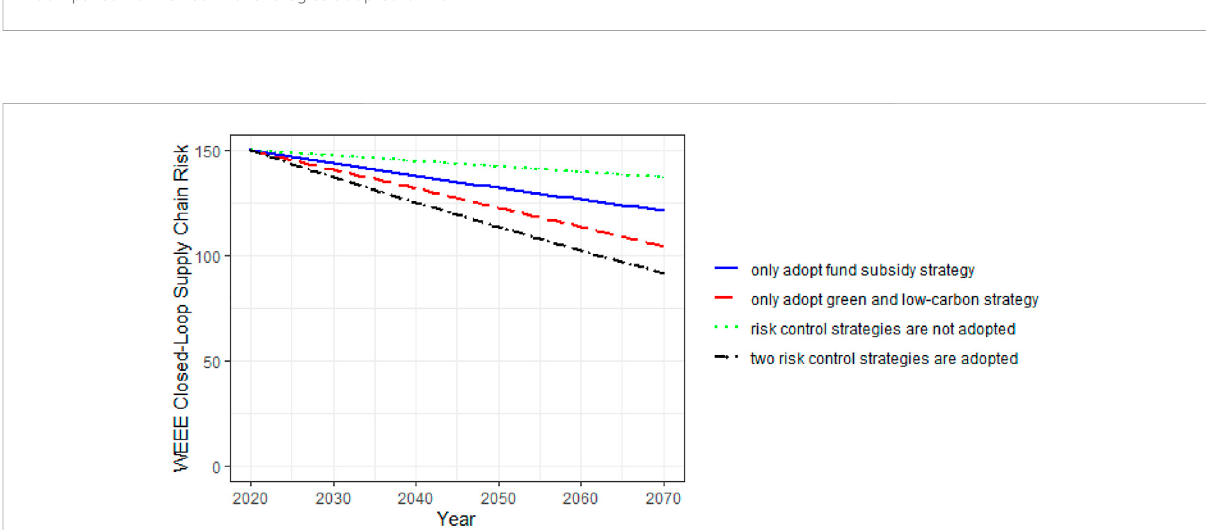
FIGURE 4 Comparison of risk control strategies adopted or not.